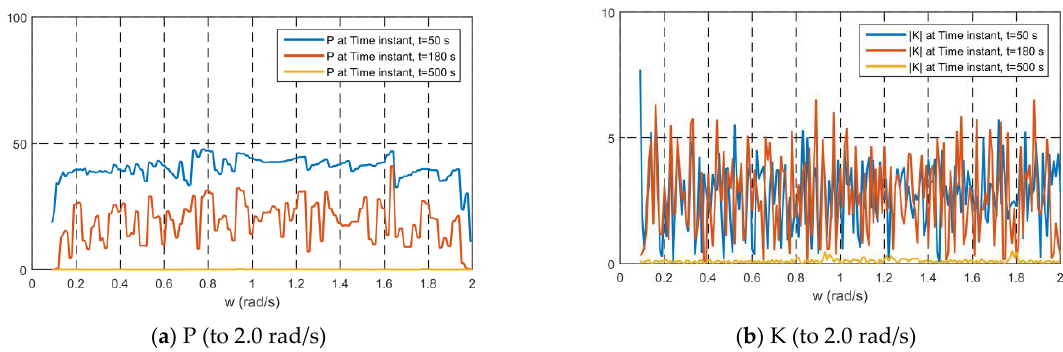
Figure 20. Error covariance and Kalman gain when using Modified TF, ( a ) P (to 2.0 rad/s); ( b ) K (to 2.0 rad/s).